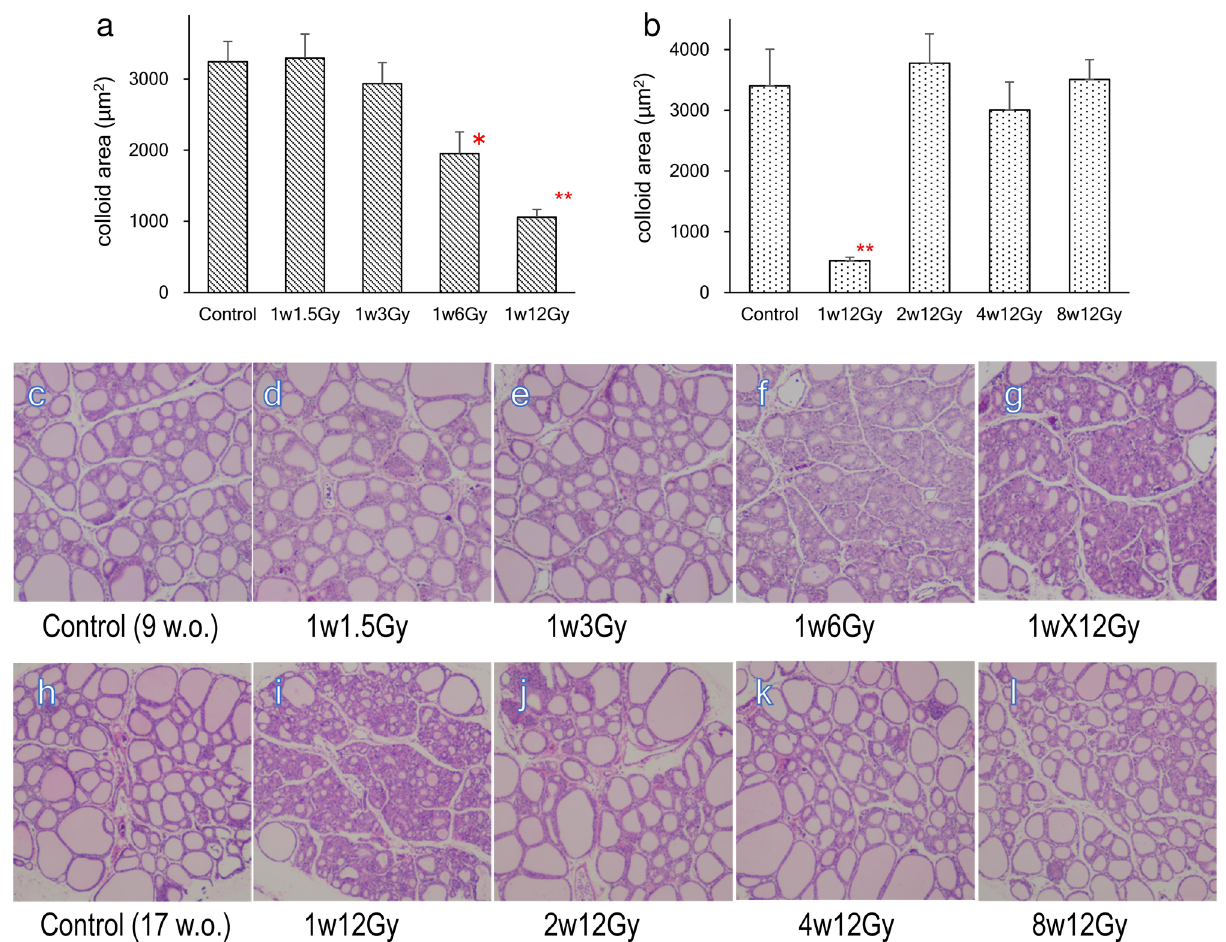
to 12 Gy of X-rays at 1, 2, 4, and 8 weeks old ( b ). The follicular sizes were decreased by the x-irradiation at 6 Gy and 12 Gy ( c–g ). The reduction was not observed in rats irradiated at 2 weeks old or later ( h – l ). *, ** indicate significant difference from Control (* p < 0.05, ** p <